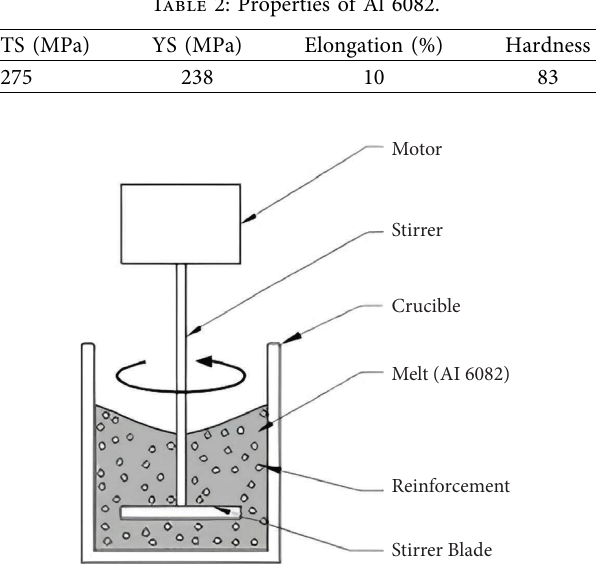
Figure 1: Stir casting